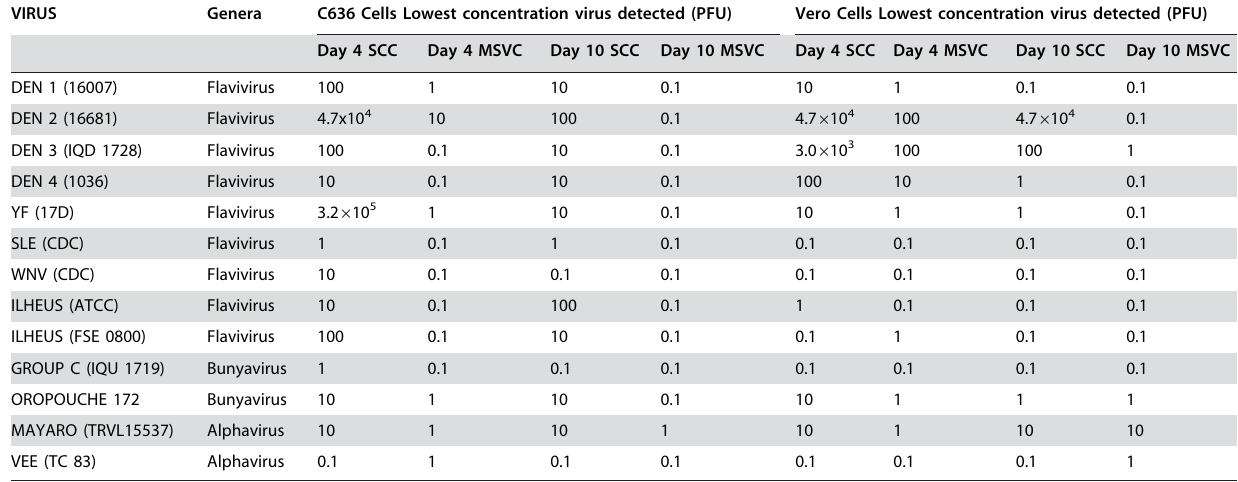
Table 1. Comparison of stock virus detection by SCC and MSVC. .. ... .... ... ... .... ... ... .... ... ... .... ... ... .... ... ... .... ... ... .... ... ... .... ... ... .... ... ... .... ... ... .... ... ... .... ... ... .... ... ... .... ... ... .